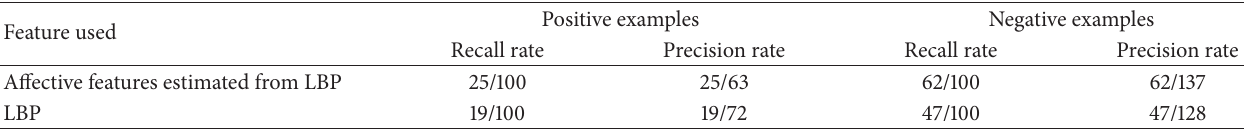
Table 6: Comparison of pleasant/unpleasant classification results obtained with MEM using the affective features estimated from LBP and using LBP directly.